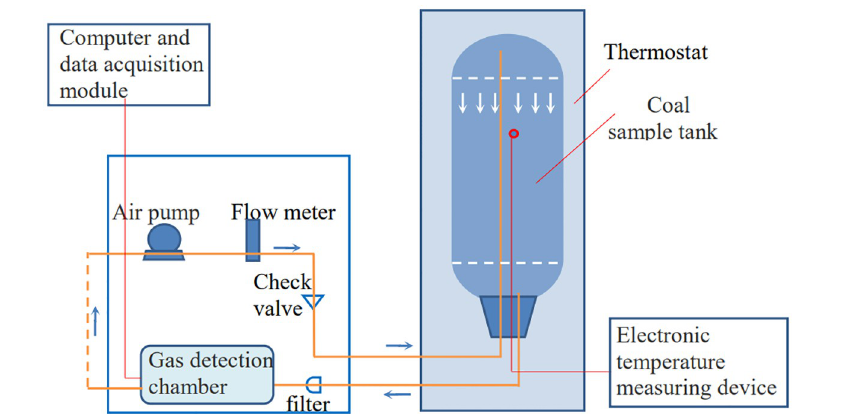
Fig 1. Schematic of sealed oxygen consumption experimental